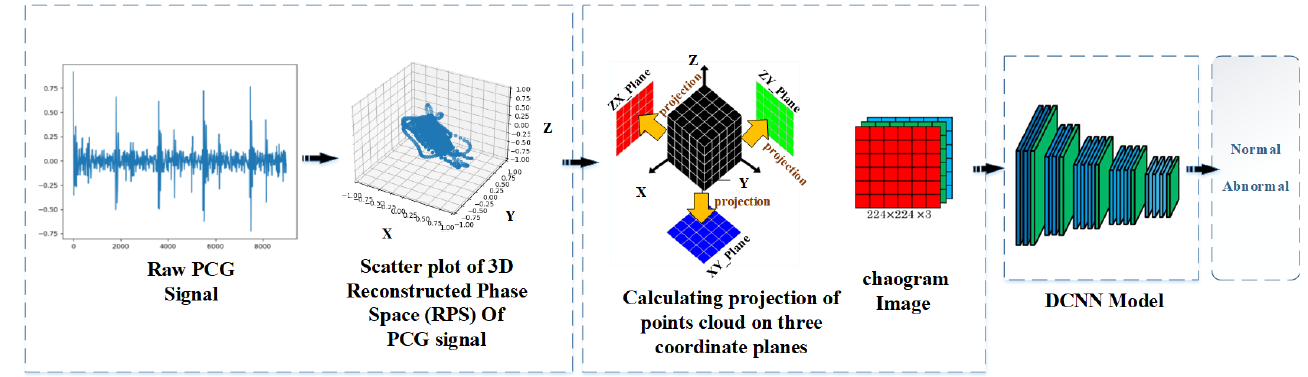
Figure 2. Flow diagram of the proposed approach for PCG signal classification: (1) building RPS from the original PCG signal; (2) projections of data represented in RPS are calculated on the XY, XZ, and YZ coordinate planes to form the red, green, and blue channels of the corresponding RGB image; (3) the chaogram is formed as a compatible input for a deep convolutional neural network; (4) a DCNN model pretrained on the large ImageNet Dataset is used for learning the extraction and classification of the chaogram’s high-level features; (5) the PCG signals are classified as normal or abnormal signals using the trained DCNN